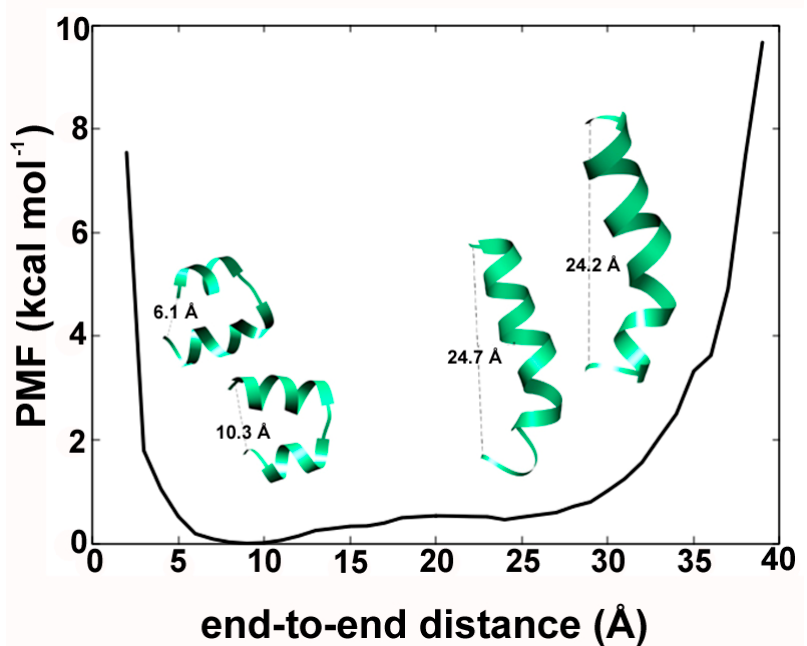
Figure 4. The reweighted potential-of-mean-force values in kcal mol − 1 as a function of end-to-end distance of Alm calculated for each step in the combined trajectory. The energy minimum lies for a distance value of 10 Å which denotes a highly bent